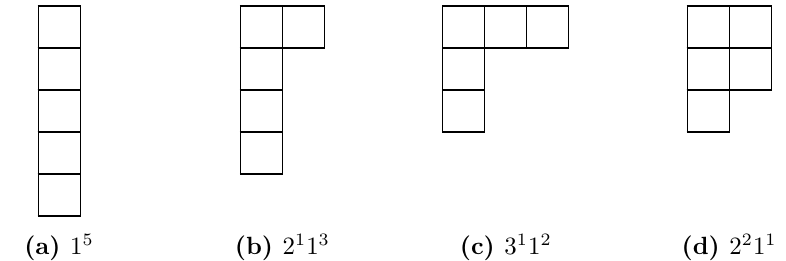
Figure 1. The large N expansion of h W i SU( N ) for any (cid:12)xed R can be computed up to order 1 =N 2 , R in terms of four correlators of multiply-wound Wilson loops. Each correlator of multiply-wound Wilson loops has its own Young diagram, and the four relevant ones are displayed in this (cid:12)gure. They are shown for the particular example of an arbitrary irreducible representation R with k = 5 boxes in its Young diagram. The (cid:12)rst one contributes at leading order, and at 1 =N 2 order. The second one contributes at 1 =N order. The last two ones contribute at 1 =N 2